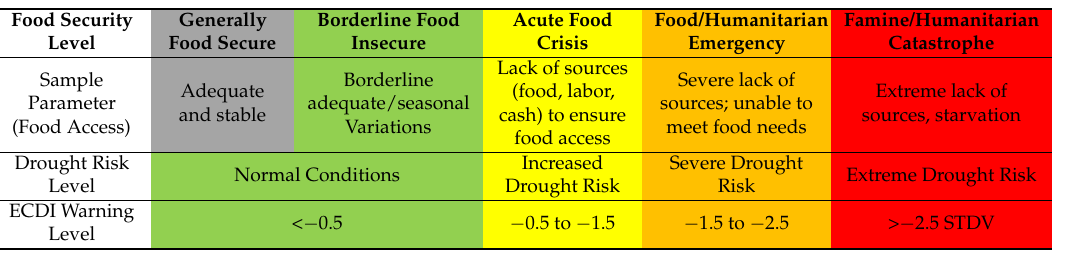
Table 1. Comparison of MSF food security warning levels and ECDI warning